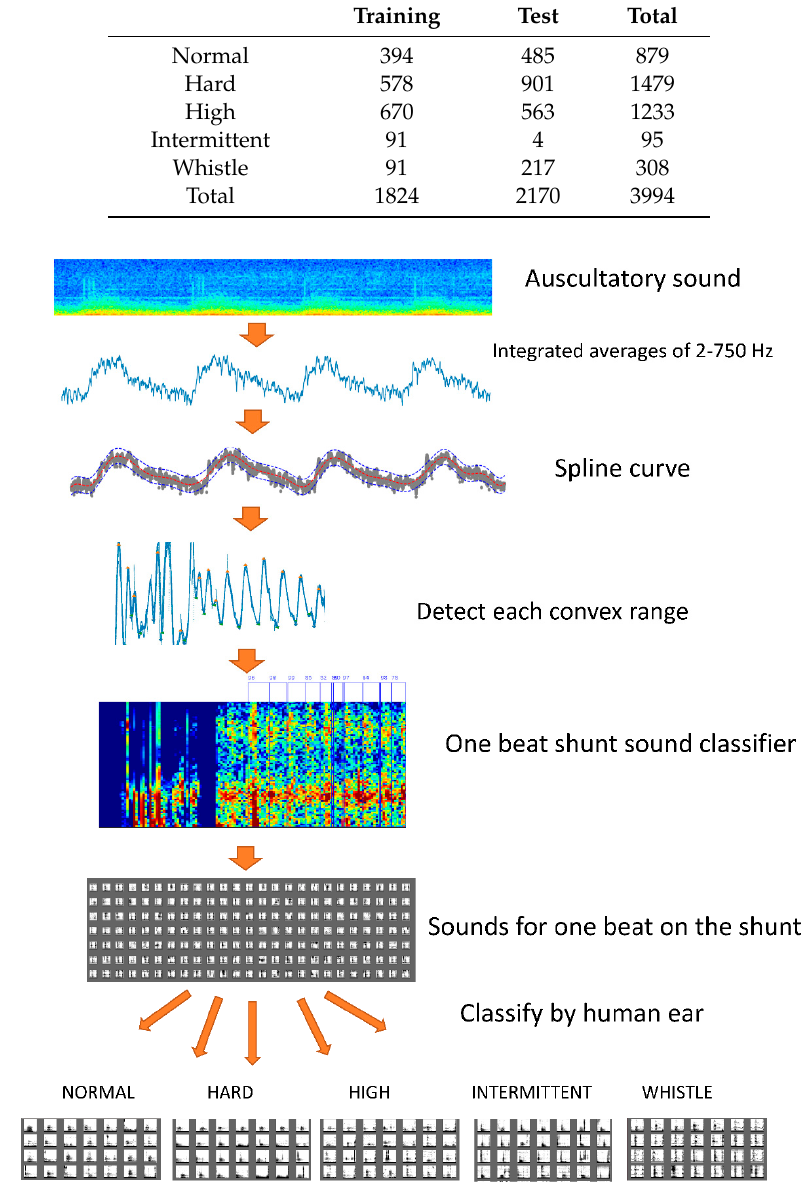
Figure 2. Learning preprocessing. A spline curve was created to eliminate noise from one auscultation sound. We extracted a number of convex curve ranges from the created spline